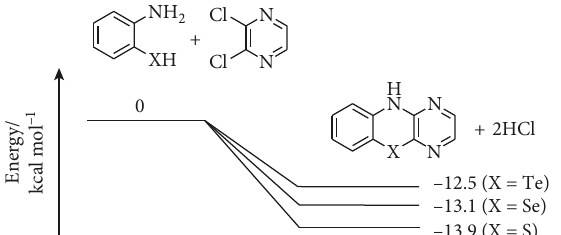
Figure 2: Comparison of free energy changes for the ring closure of 10 H -pyrazino[2,3-b][1,4]benzotellurazine and its sulfur and selenium congeners.